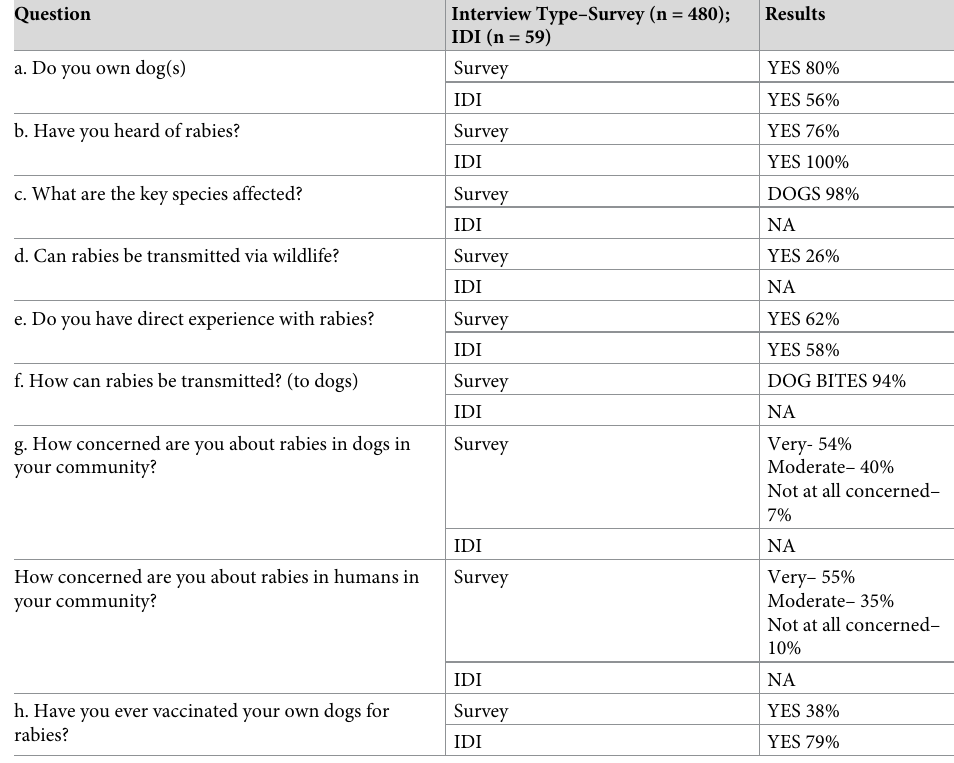
Table 4. Awareness of Rabies. The outcome of ‘awareness’ based questions about rabies in the survey and IDI. Ques- tions asked are listed in the first column. S1 and S2 Data.